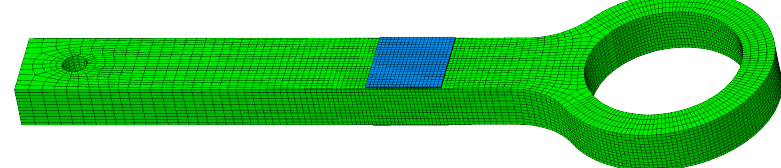
Figure 2. Mesh of complete assembly of pristine necked lug FE